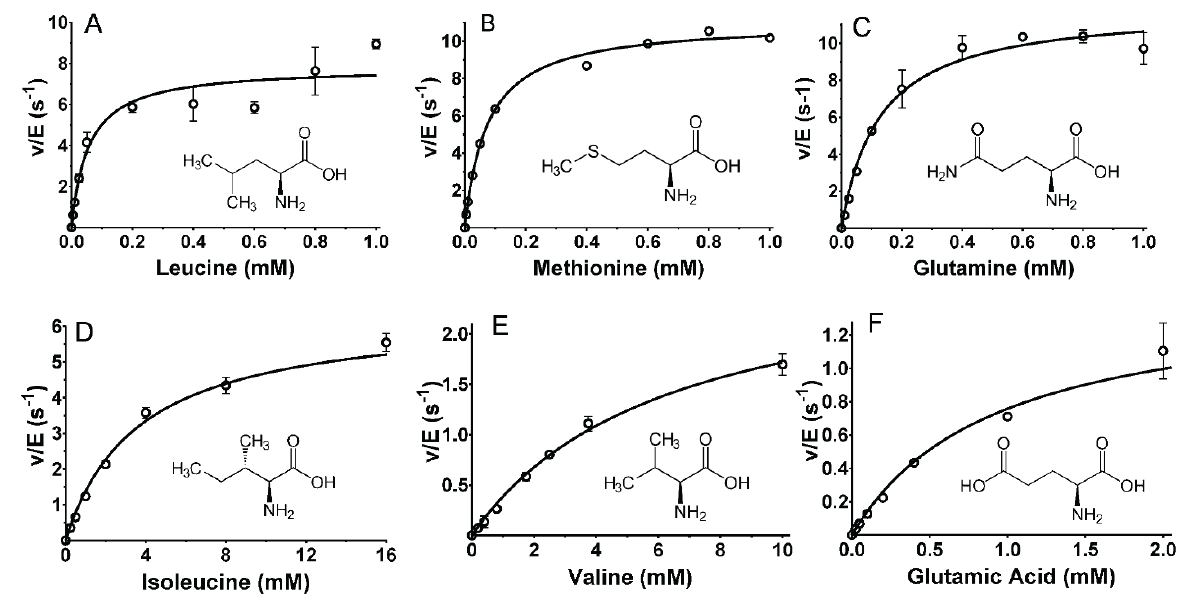
Equation (1). Data points are the average of three replicates. The structures of each amino acid are shown with each plot.